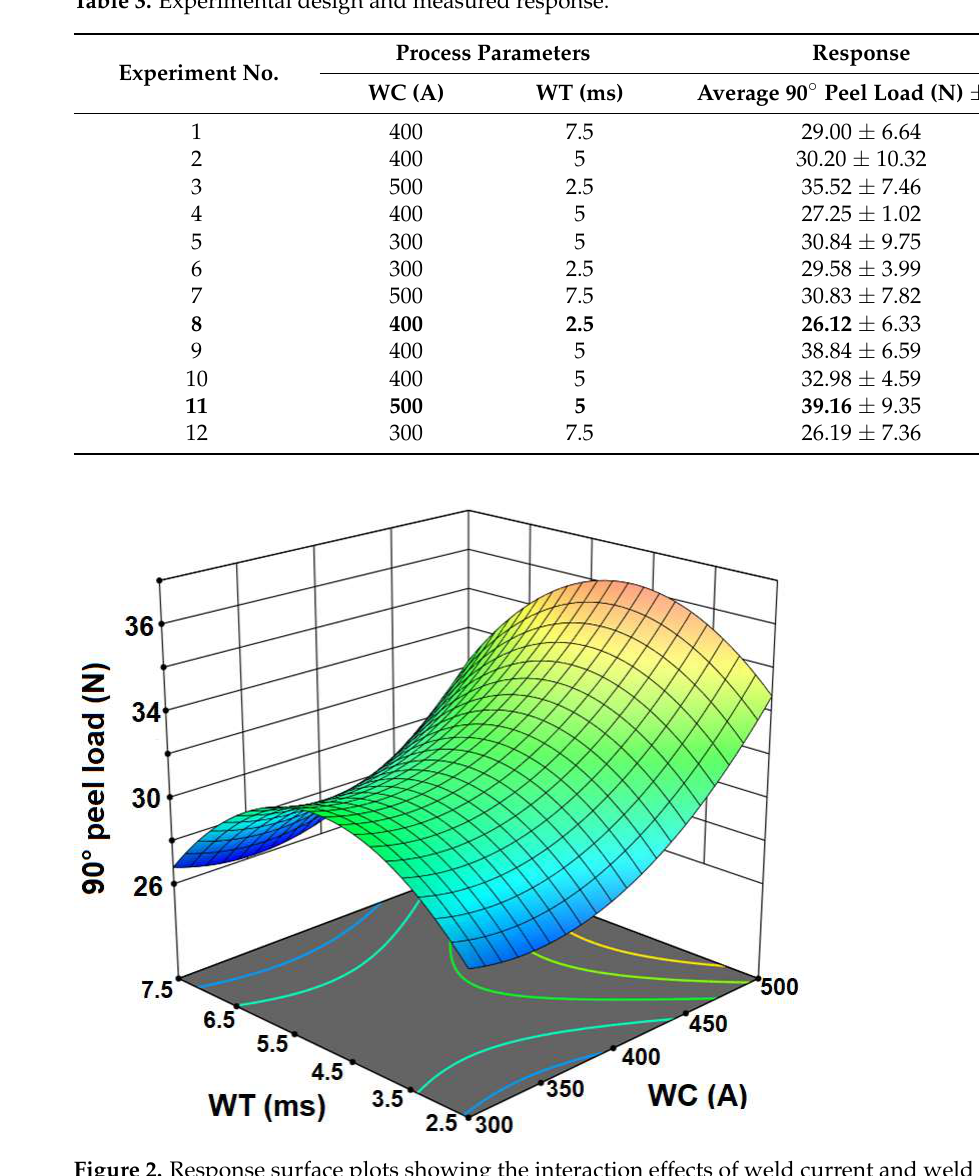
Figure 2. Response surface plots showing the interaction effects of weld current and weld time on the average peak load (PL). Table 3. Experimental design and measured response.